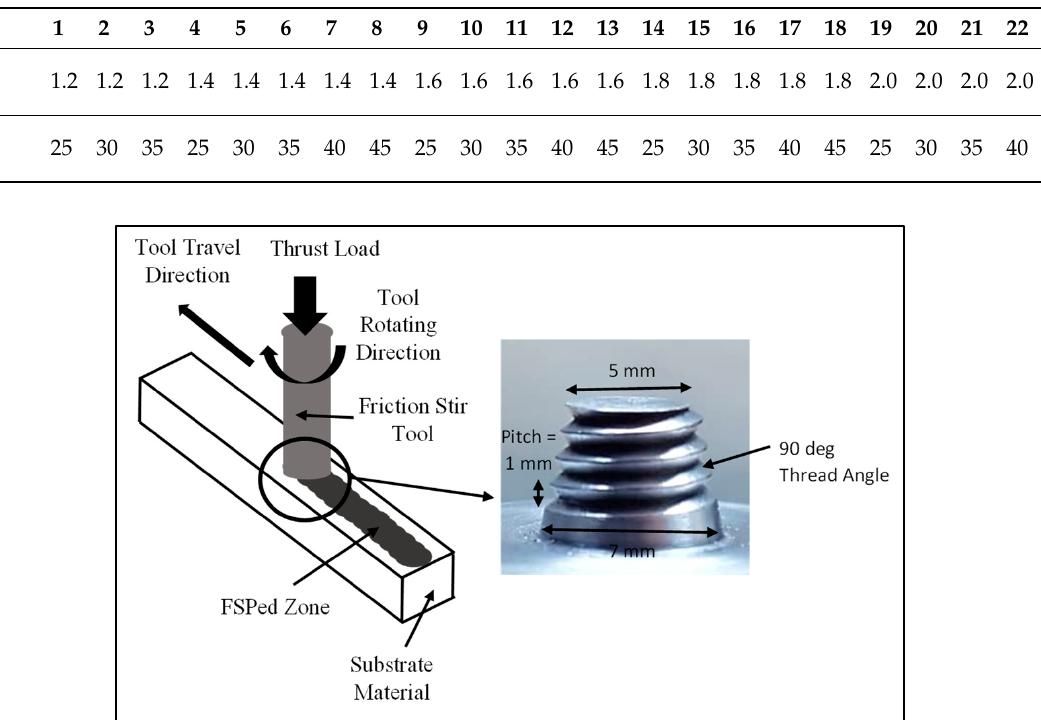
Figure 1. Recycled AA 6063.